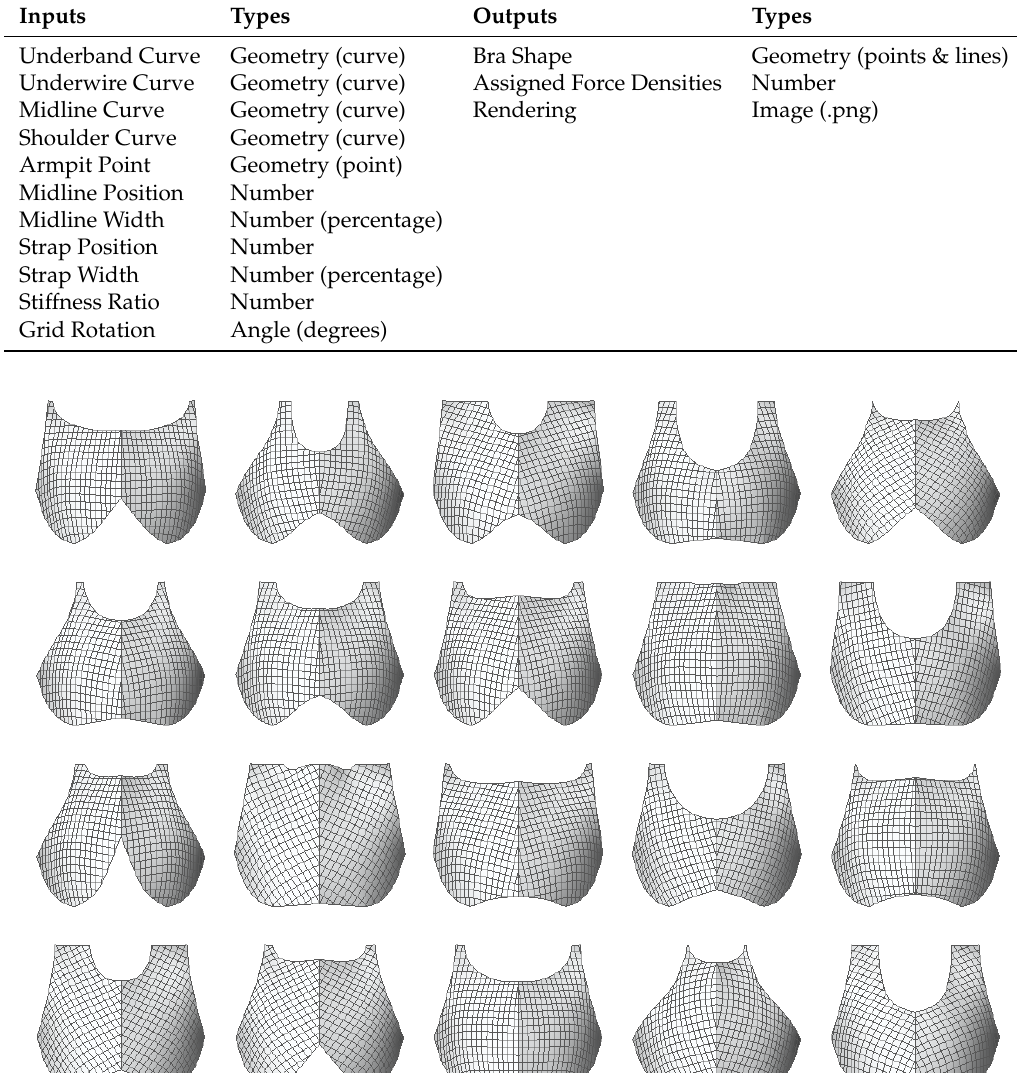
Table 4. Bra generation inputs and outputs.